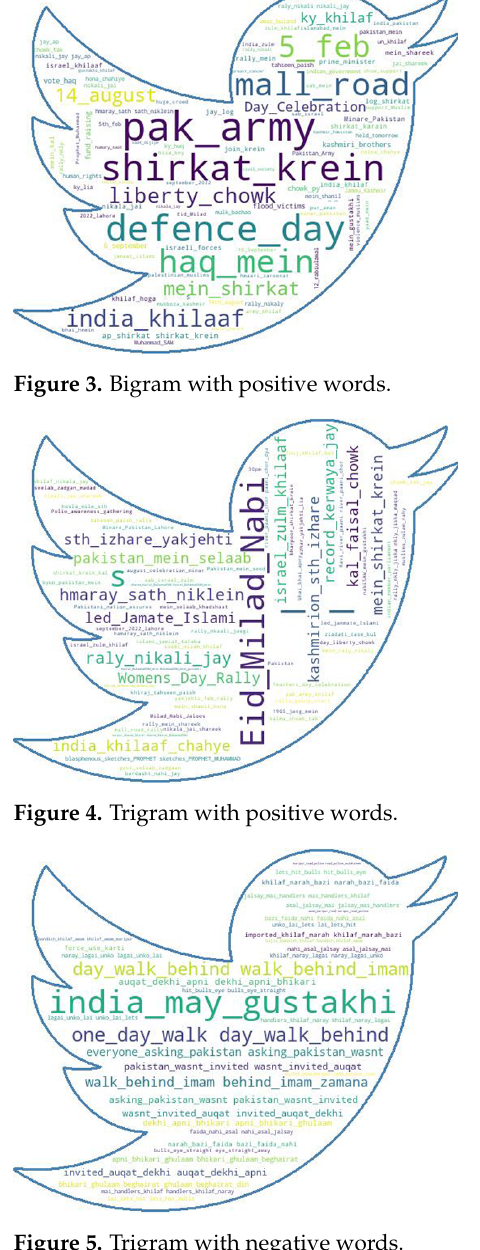
Figure 5. Trigram with negative